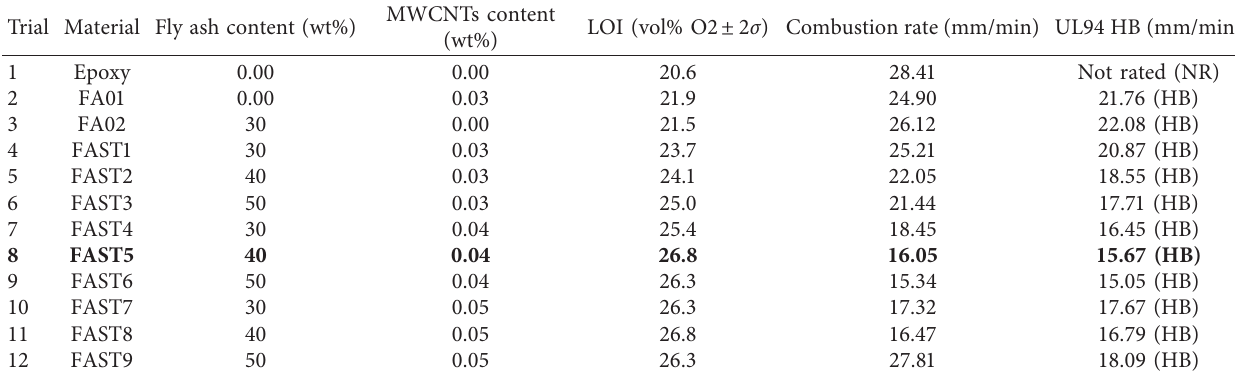
The bold values indicate that at the fabrication rate of 40 percent by weight of fly ash combined with 0.04 percent by weight of MWCNTs, the mechanical properties of the material are improved more than the others. Table 4: Results for flammability tests (reaction to small flame) oxygen index (OI) and UL 94 for fly ash/MWCNTs/epoxy nanocomposites. Trial Material Fly ash content